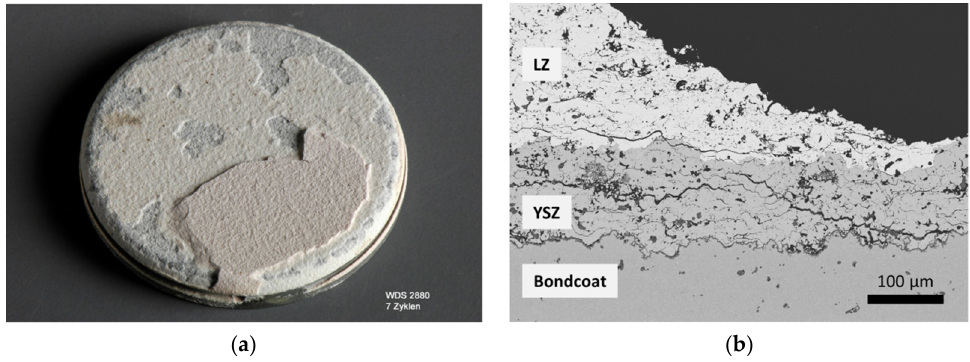
Figure 5. ( a ) Double ‐ layer sample, LZ sprayed with TriplexPro™ ‐ 210 at low power (22 kW) and with Ar–He plasma gas mixture (spray distance 90 mm, powder 321 M, feed rate 8 g/min) after seven thermal cycles; ( b ) back ‐ scattered electron image of the cross ‐ section.